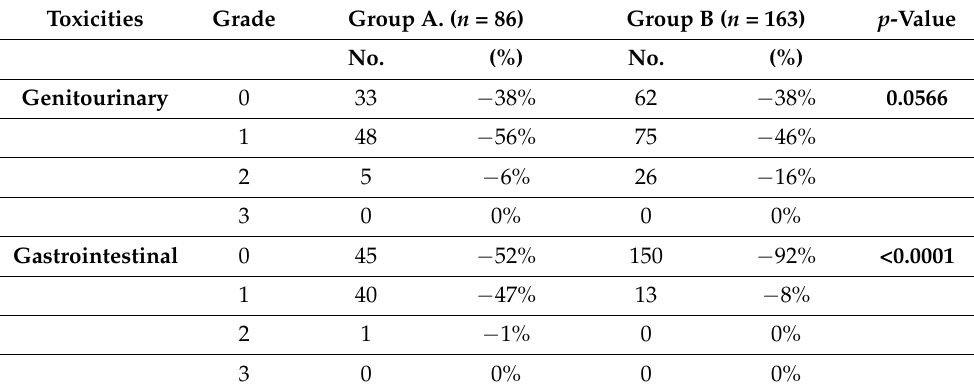
Table 4. Acute toxicity between Group A and B.